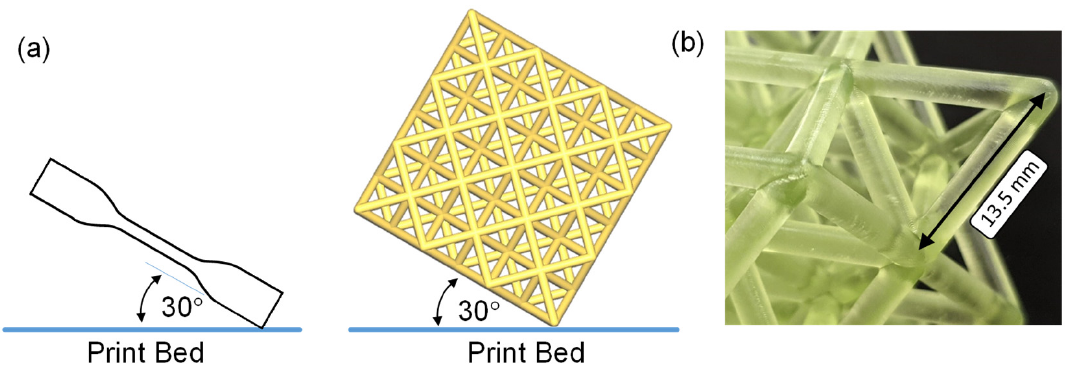
Figure 1. ( a ) A schematic of the dogbone and lattice structure print orientation. ( b ) An image of the high-resolution SLA 3D print quality (Resin